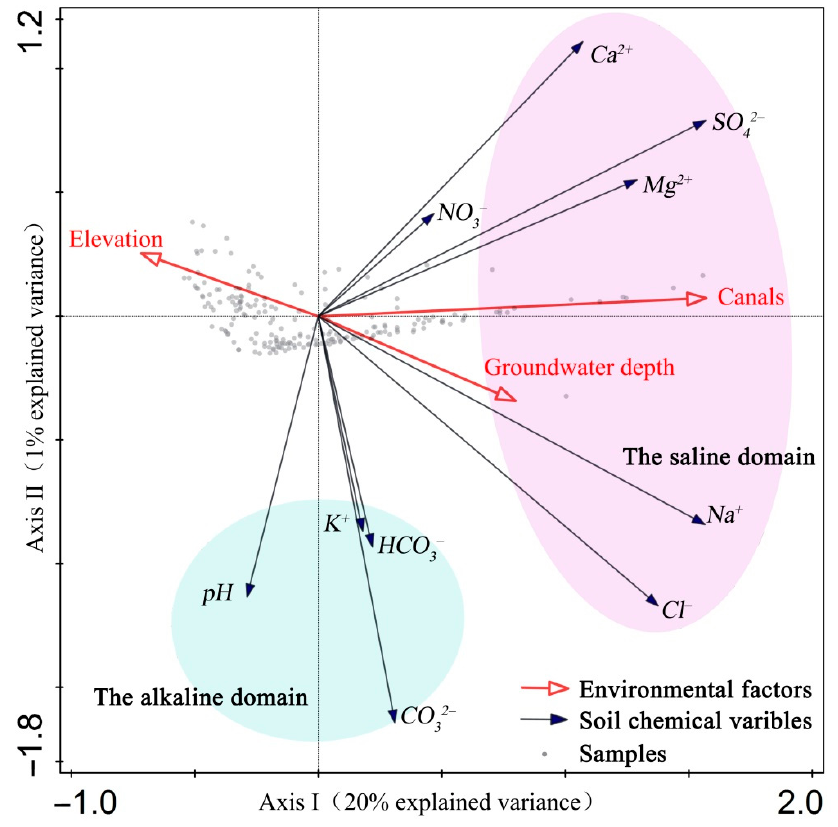
Figure 3. Ordination diagrams from the correlation-based direct gradient analysis (RDA). Variability explained by the first two axes (correlation triplot) of the relationship between soil chemical variables and the environmental factors for the 204 sampling points.